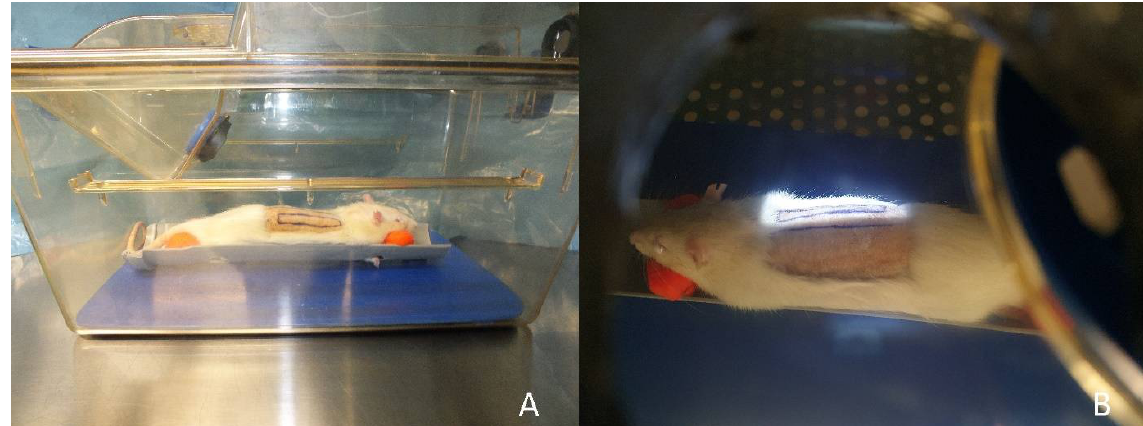
Figure 1. Harvest of two modified McFarlane flaps: ( A ) preoperative markings parallel and 1 cm lateral to the spine; ( B ) two flaps harvested; ( C ) reinsertion of the flaps.